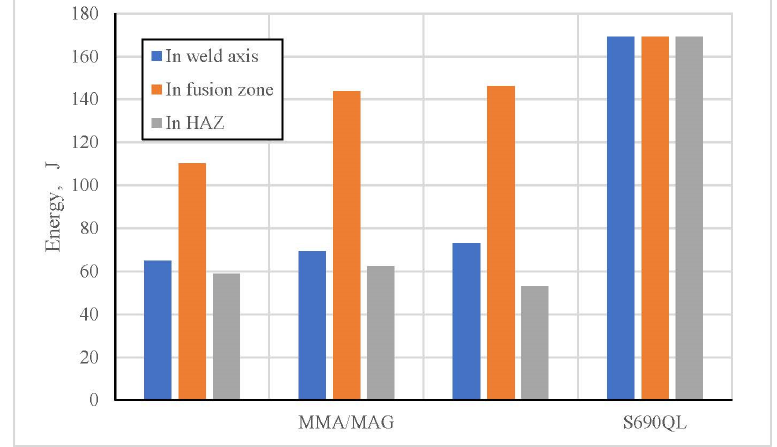
Figure 8. Fracture energy histogram of the test samples with a notch on the face side of the welds.